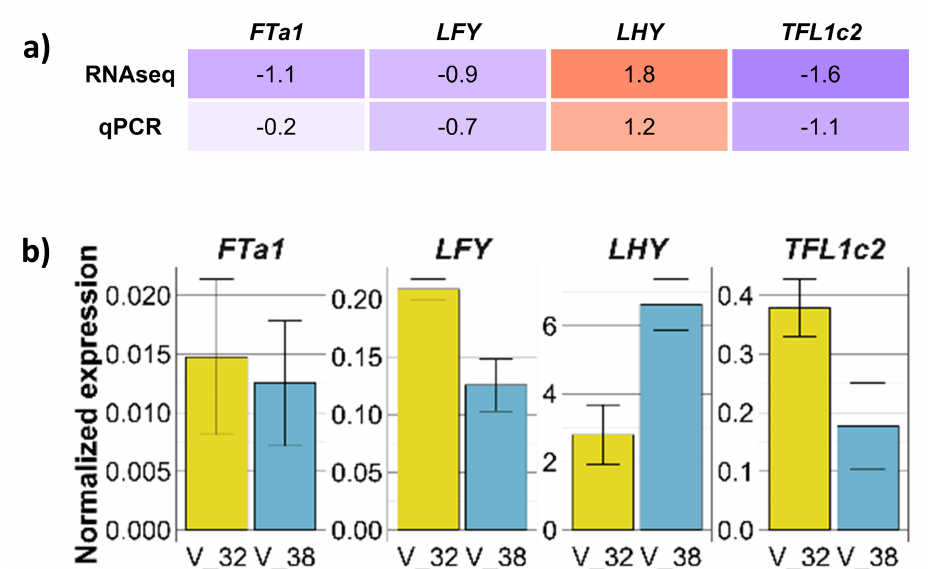
Figure A2. Comparisons between C. echinospermum and C. reticulatum and between C. echinospermum and cultivated Cicer share the same direction of expression regulation. The heatmap displays FC values for the comparisons of C. arietinum (A), ICCV 96029 mutant (M), and C. reticulatum (R) with C. echinospermum (E) in leaves BF ( a ) and leaves AF ( b ). It is evident that the color in each row (corresponding to individual genes) does not change between the columns (corresponding to each of the comparisons). Up- and downregulation are shown in red and blue, respectively. Gray cells correspond to an absence of differential expression between species/accessions. In of the entire dataset, only two outliers were found: Ca_26523 (PRMT10) and Ca_01826 (PRMT5a) , both in the leaves AF.